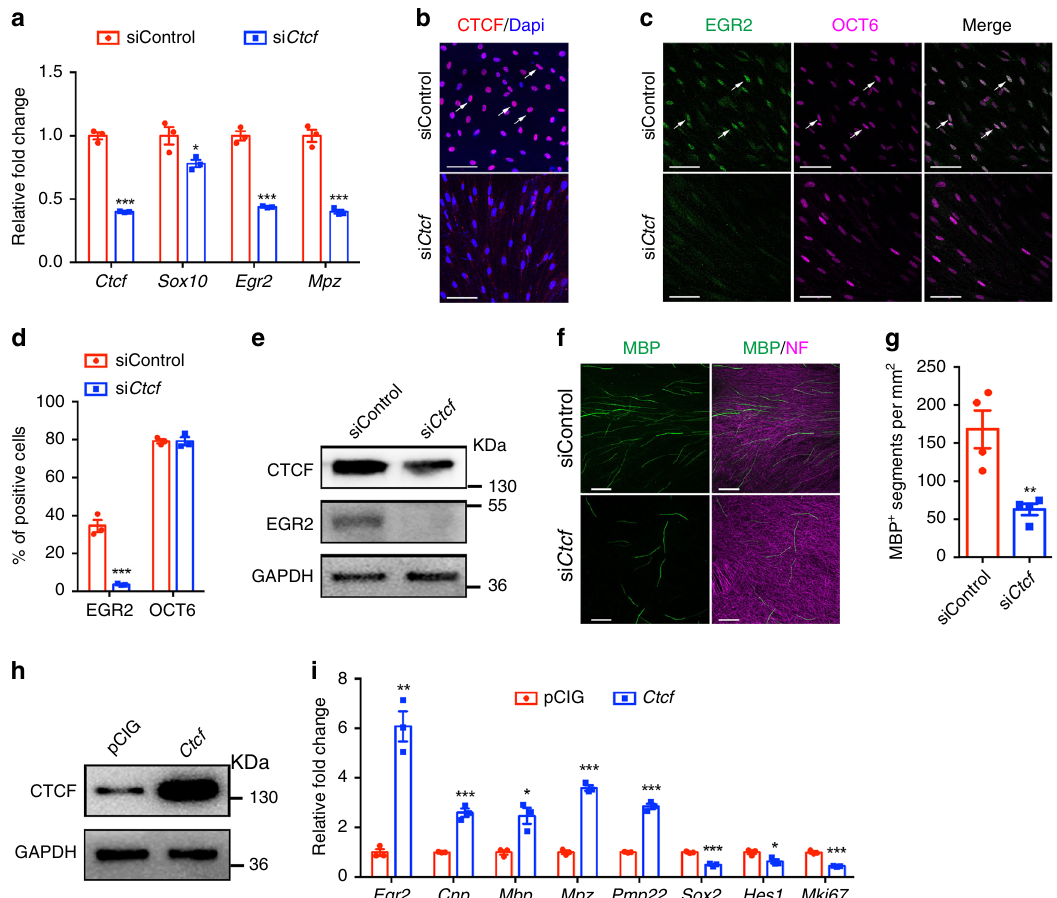
Fig. 2 CTCF is critical for rat SC differentiation in vitro. a qRT-PCR analysis of Ctcf , Sox10 , Egr2 , and Mpz expression in rat SCs transfected with control nontargeting siRNA and si Ctcf for 24 h and induced to differentiate for 9 h. n = 3 independent experiments, P ( Ctcf ) = 3.03E-05, P ( Sox10 ) = 0.0433, P ( Egr2 )